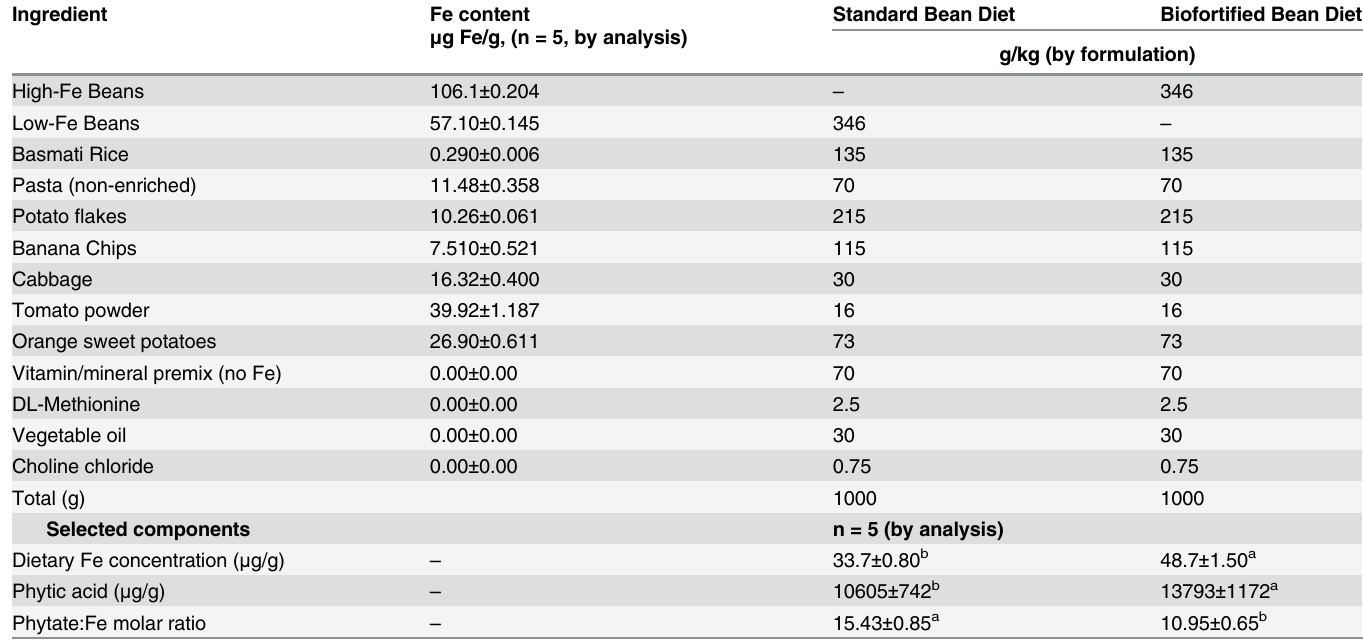
Table 1. Composition of the experimental bean based diets 1 – 3